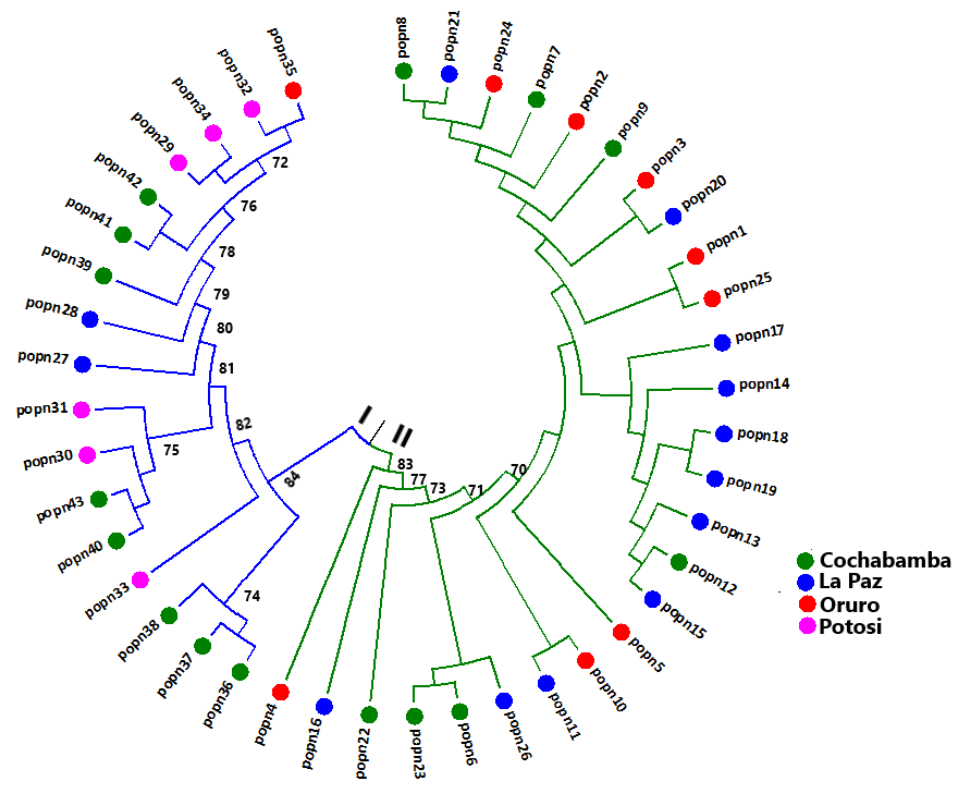
Figure 2. Unweighted pair-group method with arithmetic mean (UPGMA) tree showing the clustering pattern of the 43 populations based on Nei’s standard genetic distance. Numbers at the roots of the branches are bootstrap values. Note: Only bootstrap values ≥ 70% are shown.